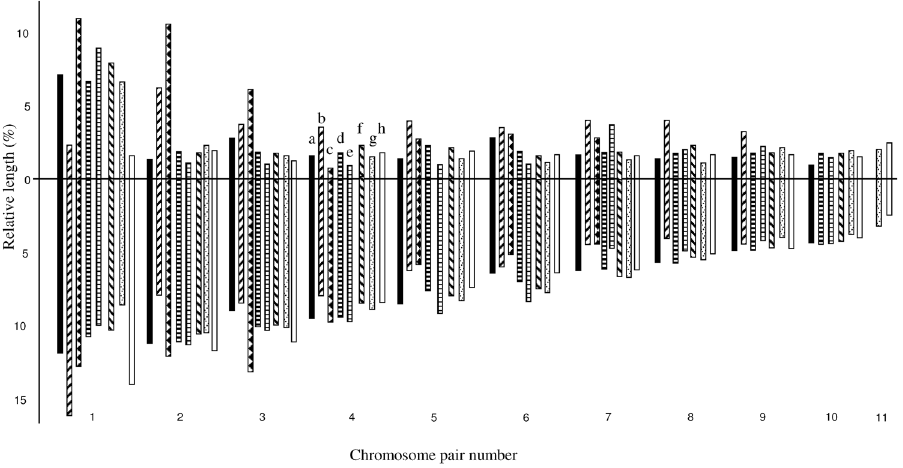
Figure 4. Idiograms representing the haploid chromosome sets. Idiogram representing the haploid sets of eight species: a Echinochasmus sp. b Episthmium bursicola c Echinochasmus beleocephalus d Echi- nopharyphium aconiatum e Istmiophora melis f Hypoderaeum conoideum g Sphaeridiotrema globulus h Echi- nostoma revolutum b, c - data of Baršienė and Kiselienė (1990) d, e, f, h data of Baršienė (1993) g data of Mutafova